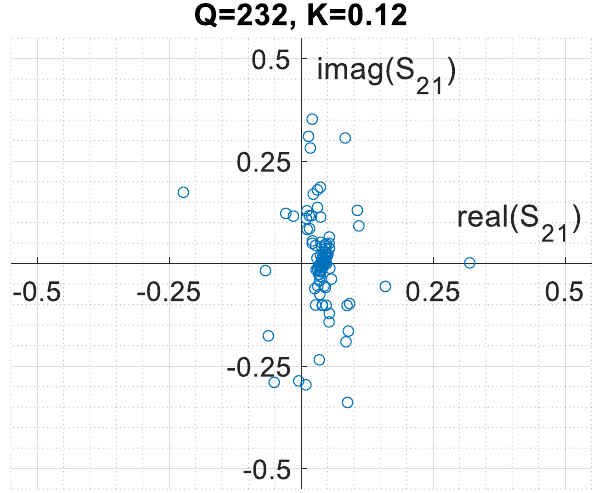
Figure 1. Scatter plot of 𝑆 21 and an indication of the Q and K parameters related to an empty RC ( up ) and the same RC with the insertion of lossy elements ( down ).